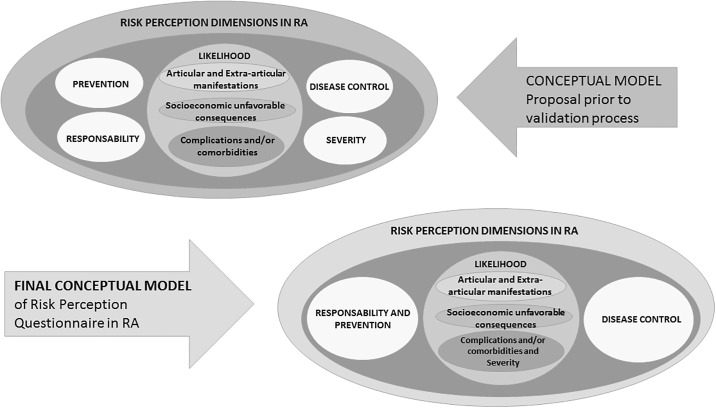
Theoretical models of risk perception dimensions.The figure shows in the left oval, the initial conceptual model and in the right oval the final conceptual model constructed with the results of the factor analysis.